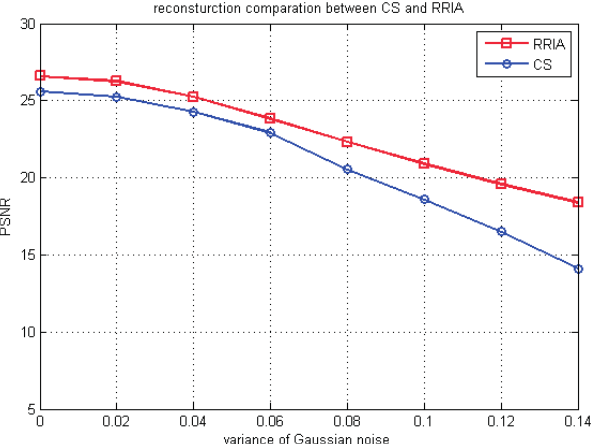
Figure 8. PSNR comparison for CS and RRIA with different variance Gaussian